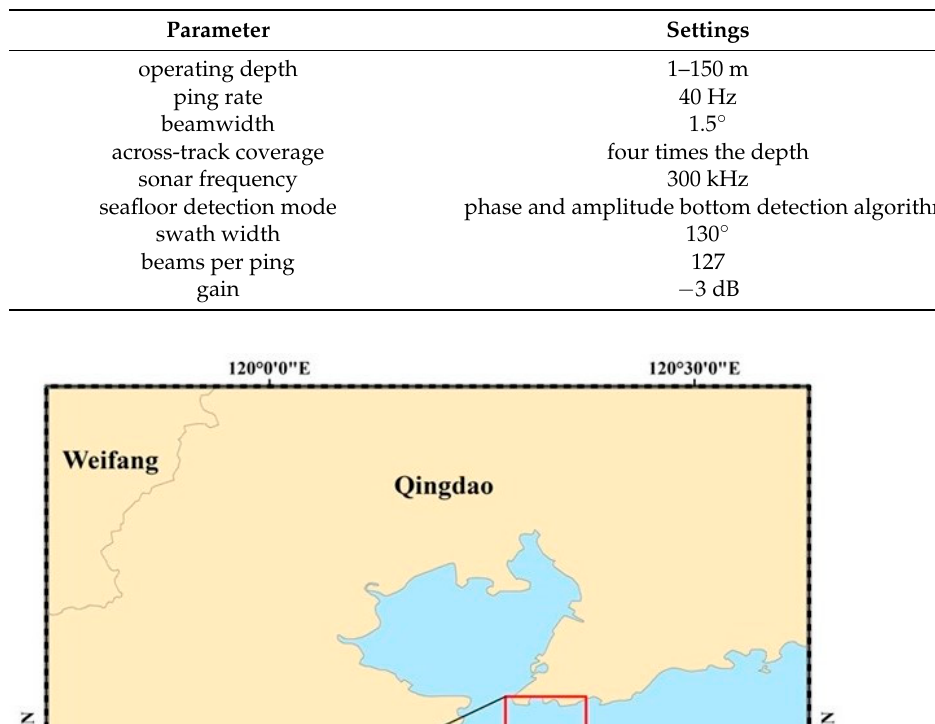
Table 1. Kongsberg Simrad EM3000 multibeam echo-sounder system (MBES) basic specifications.